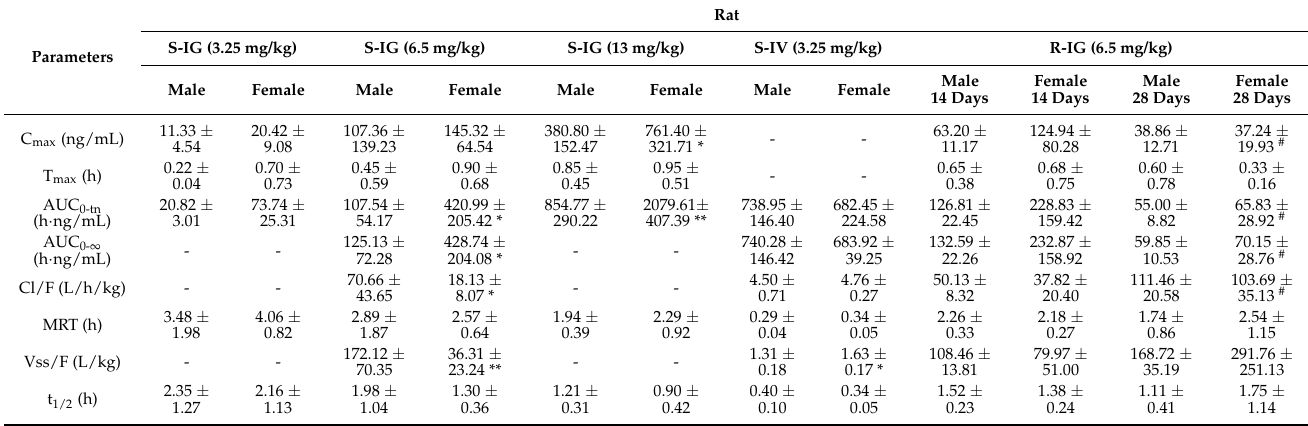
Table 1. Pharmacokinetic parameters of HY-071085 after single-dose intravenous and intragastric administration, and repeated-dose intragastric administration in rats (mean ± SD).